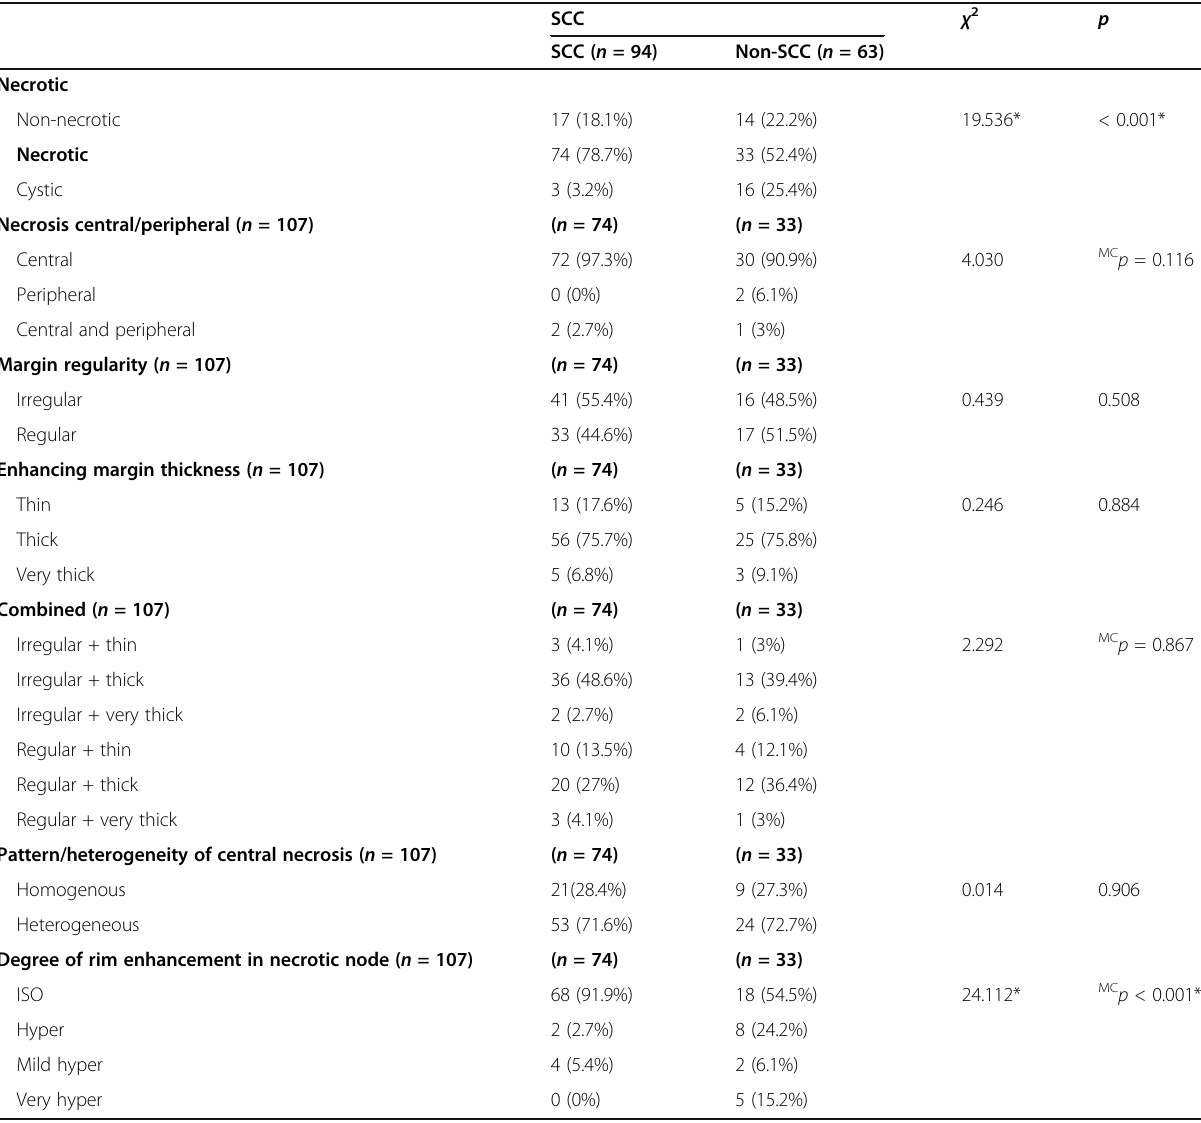
Table 4 Comparison between the two studied groups according to different imaging parameters SCC χ 2